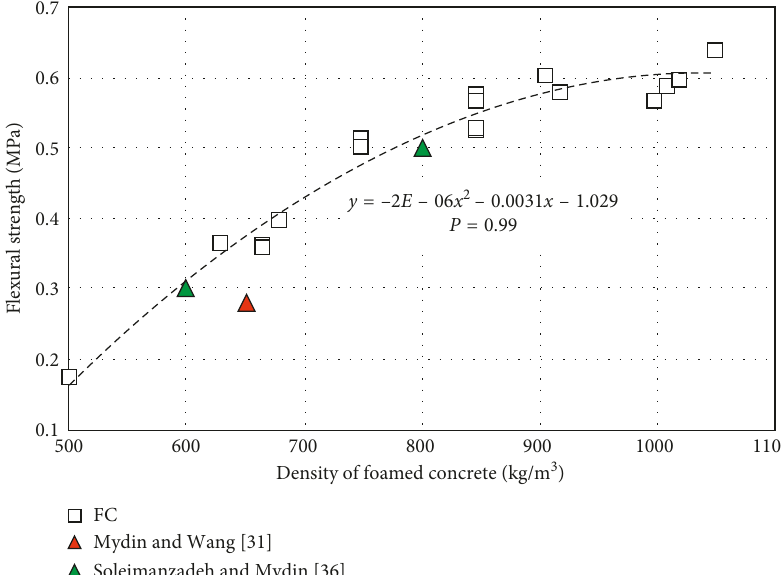
Figure 7: Flexural strength as a function of density of foamed concrete.